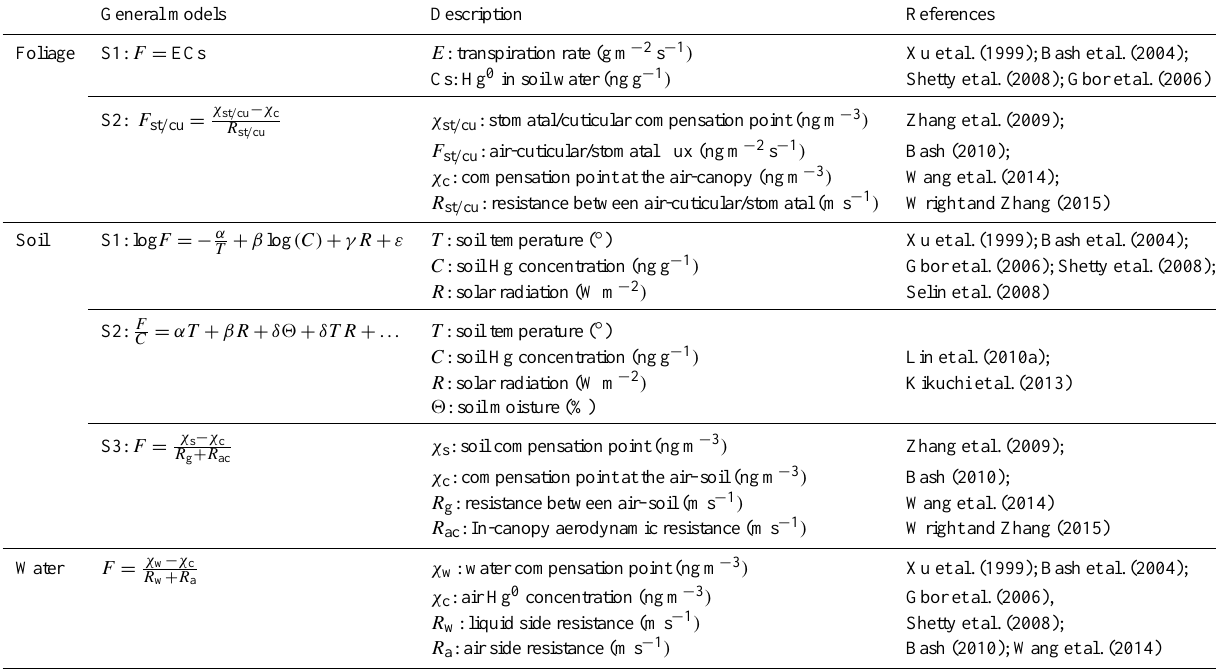
Table 2. A comparison of natural surface mercury flux models. General